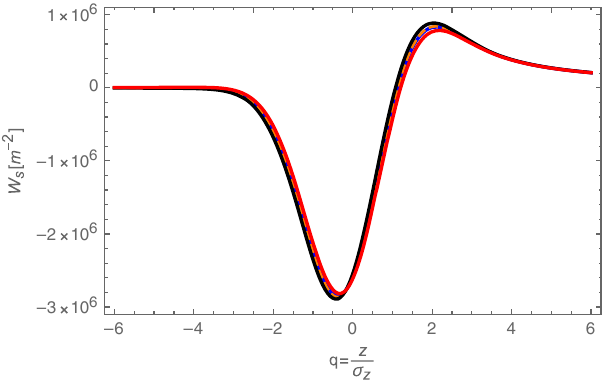
FIG. 5. The longitudinal wakes at various horizontal positions: χ ¼ − σ = ρ (in black color), 0 (blue), and σ x comparison to the one-dimensional theory (dashed